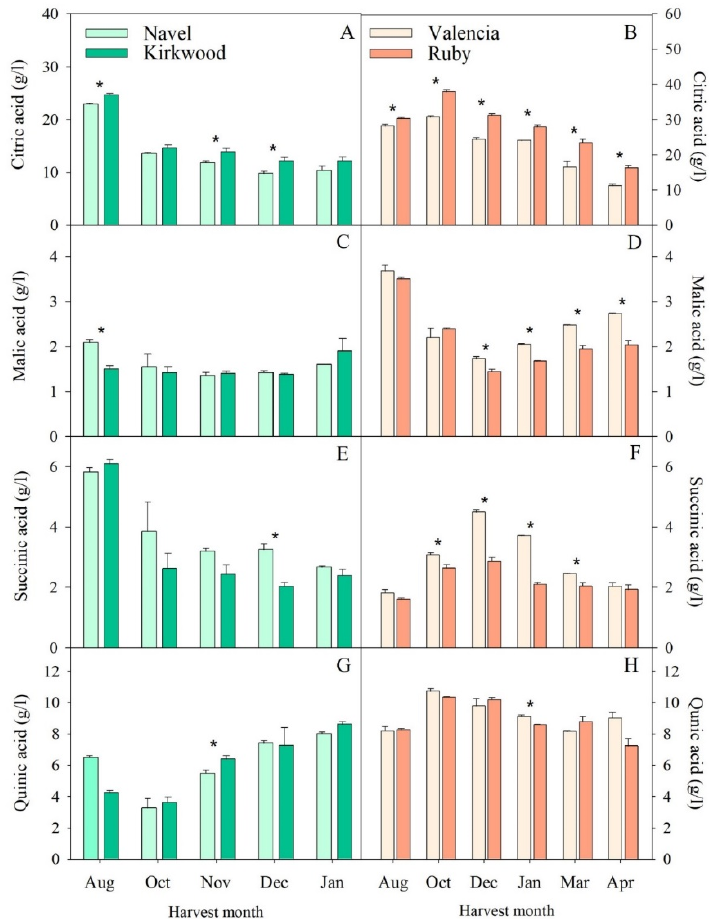
Figure 3. Concentrations of citric acid ( A , B ), malic acid ( C , D ), succinic acid ( E , F ) and quinic acid ( G , H ) in the pulps of Navel and Kirkwood ( left panel ) and Valencia and Ruby ( right panel ) oranges during late fruit development and maturation. Results are the mean of two biological replicates ± SD. Asterisks indicate significant differences between the red-fleshed K and R and the respective ordinary oranges, N and V, for each harvest month by t -test ( p ≤ 0.05).